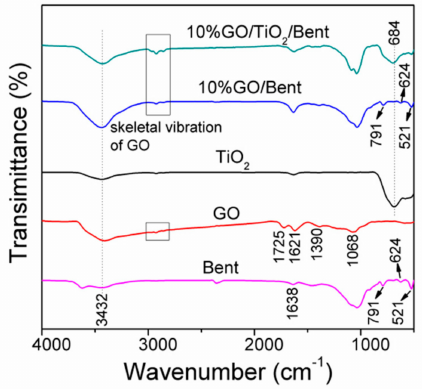
Figure 2. FTIR spectra of Bent, GO, TiO 2 , 10% GO / Bent and 10% GO / TiO 2 / Bent